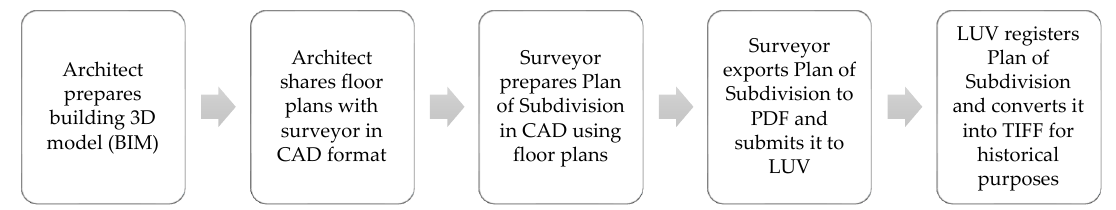
Figure 2. Building subdivision data exchange in Victoria.